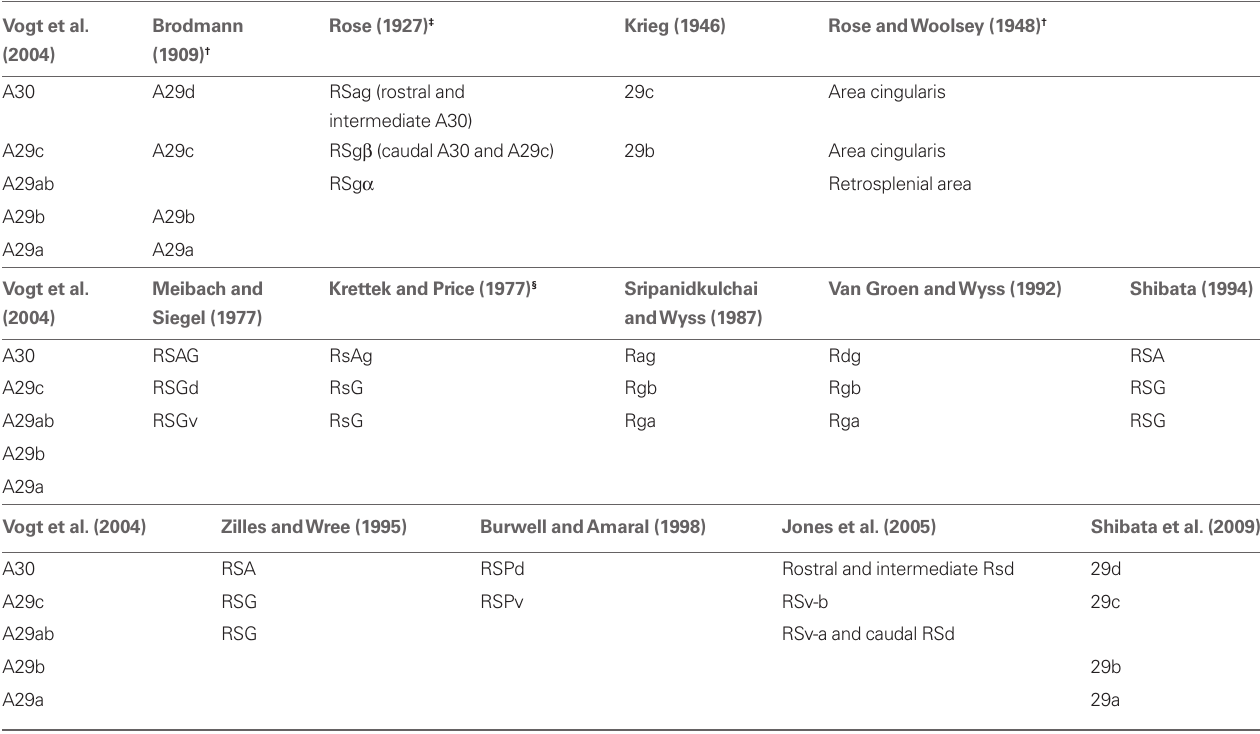
Table 1 | Comparison of nomenclatures of the retrosplenial cortex (rSC). Vogt et